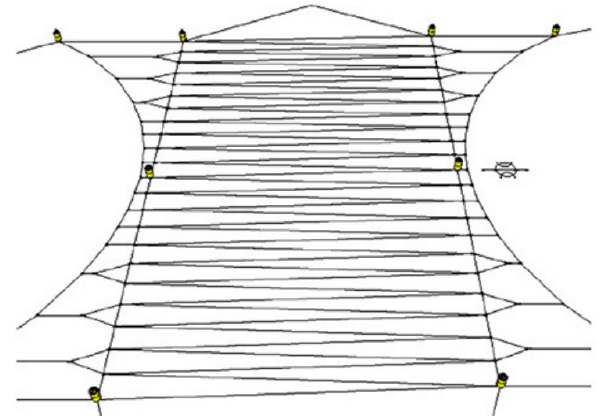
Figure 15. Buland 10 triangulated net long-line system [36].